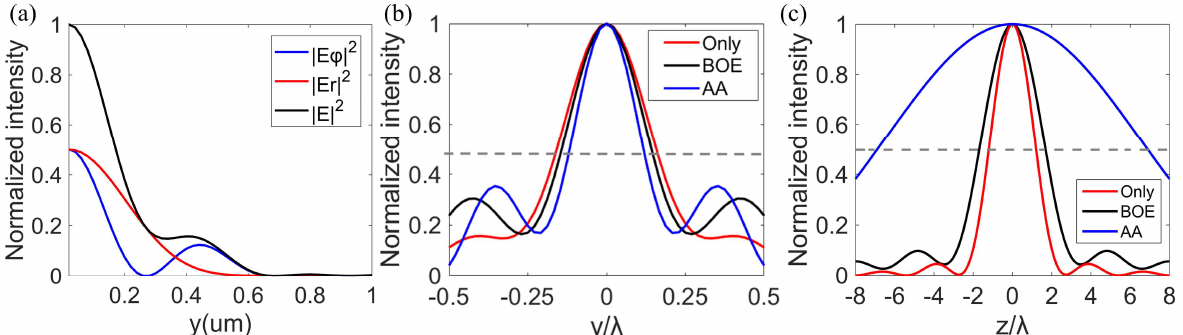
Figure 1. Theoretical calculation of the focal field of the azimuthally polarized vortex beam. ( a ) Refers to the radial normalized intensity distribution in the focal plane modulated only by the metalens. |E ϕ | 2 , |E r | 2 , and |E| 2 represent normalized intensities of the azimuthal, radial, and total components, respectively. ( b , c ) Represent the normalized intensity profiles along the y−axis and z−axis, respectively. The gray dotted line indicates the position of the half maximum intensity. Only indicates the case of only the metalens. BOE and AA indicate the case of the phase of BOE and annular aperture working with the metalens, respectively.